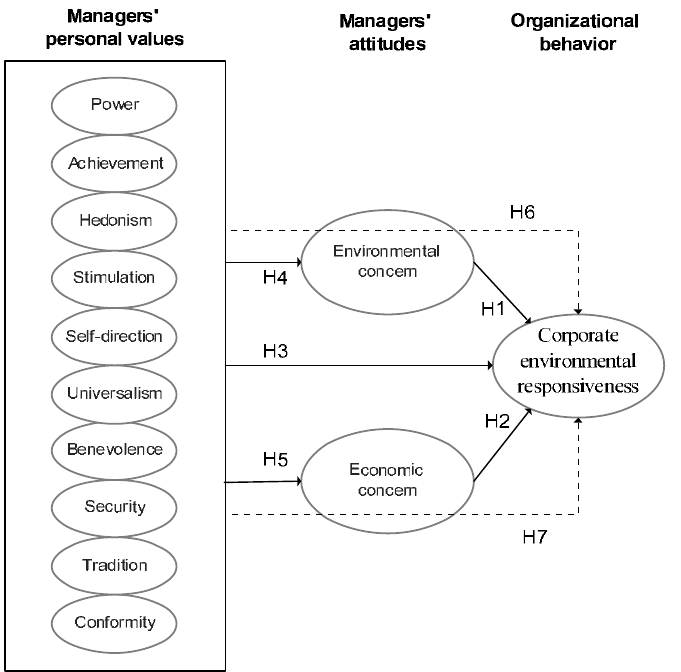
Fig. 1. Research model Source : designed by